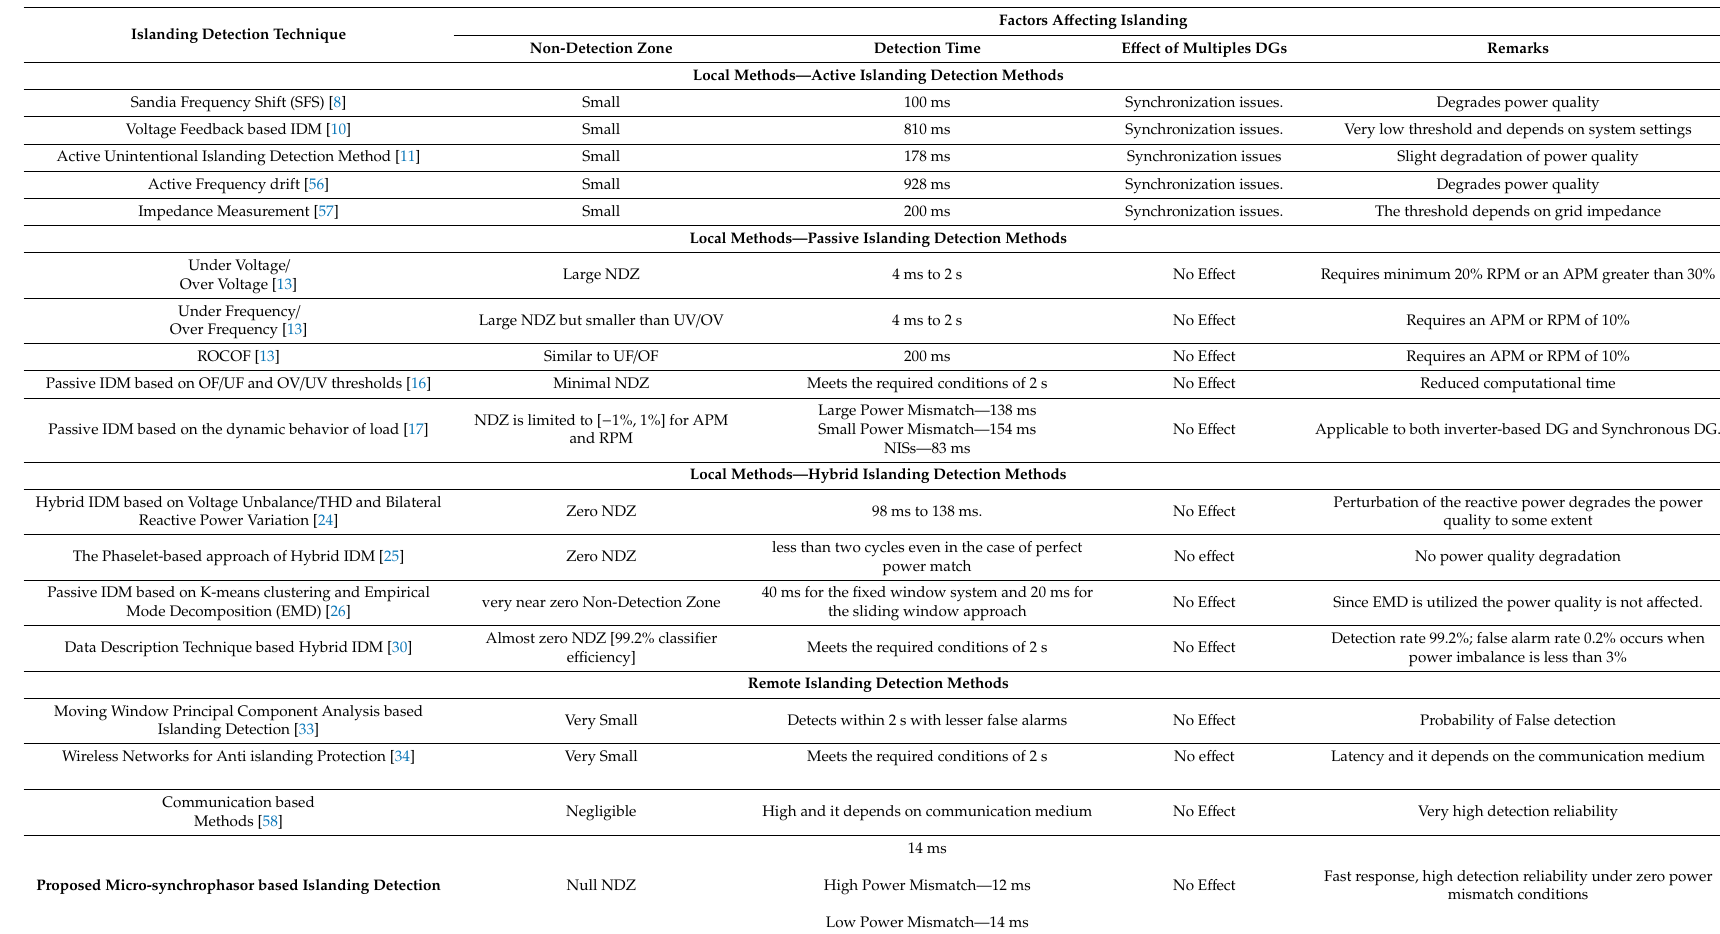
Table 6. Comparison of proposed islanding detection method with other